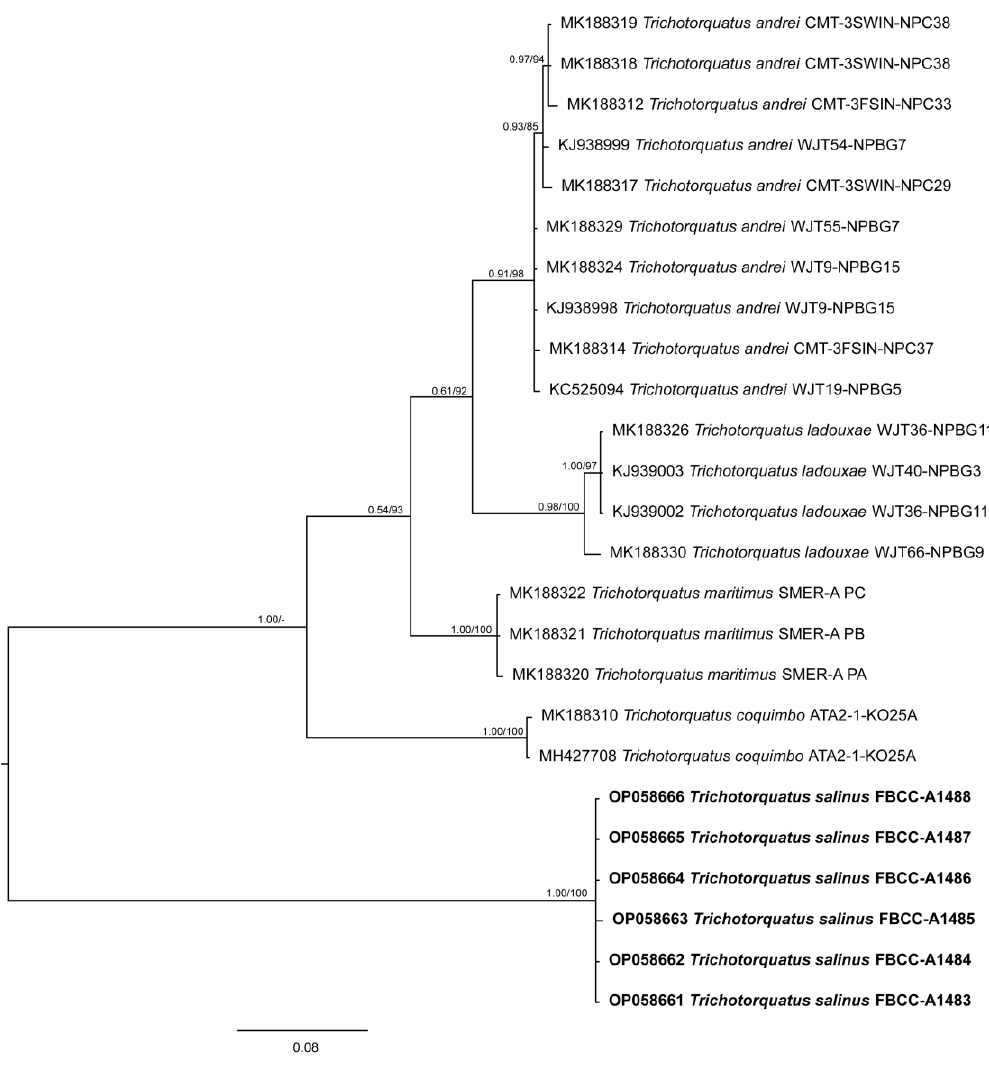
Figure 8. Bayesian Inference analysis of 16S–23S internal transcribed spacer gene sequences of orthologous type 2 operon, with posterior probabilities ( left ) and Maximum parsimony bootstrap values ( right ) on the node. Table 2. Percent dissimilarity of 16S–23S internal transcribed spacer region among the species that have the type 2 operon. Comparisons among strains in the same species are reported in bold